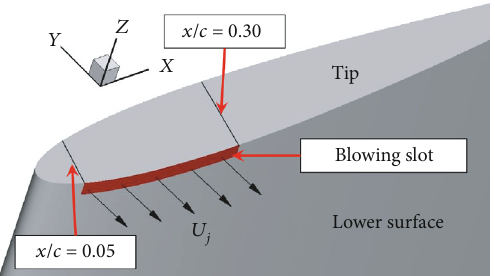
Figure 3: Schematic of normal blowing at the